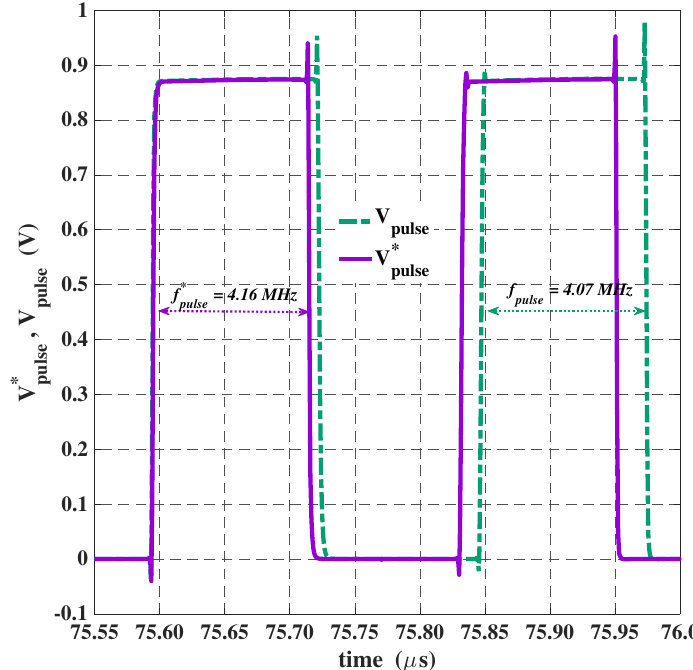
Figure 15. Pre-Layout ( V pulse ) vs. Post-Layout ( V ∗